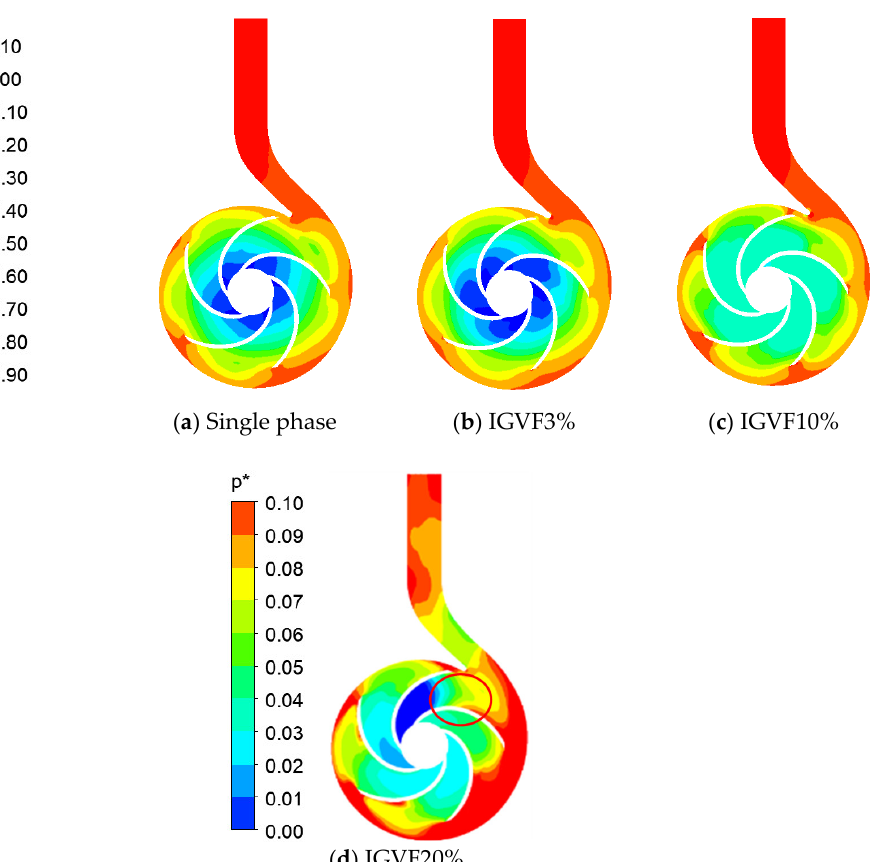
Figure 8. Variation of the mean diameter with time of the main pump components.